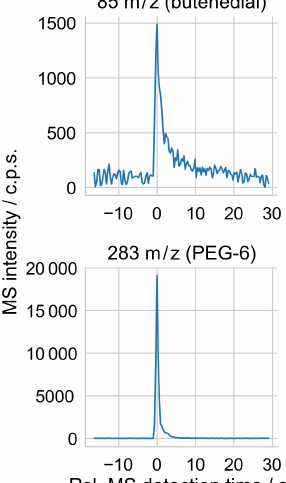
Figure 5. Sample extracted ion time series from measurement of a single droplet, whose mass spectrum is shown in Fig. 4. The peak intensities in the 85 and 283 m/z mass channels above the surround- ing background are used to quantify the abundance of butenedial and PEG-6 in the droplet,